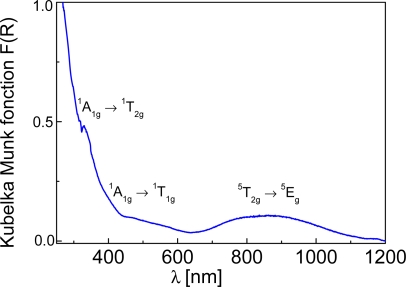
UV-Vis diffuse reflectance spectrum of 1·0.5H2O showing d–d transitions at 293 K.